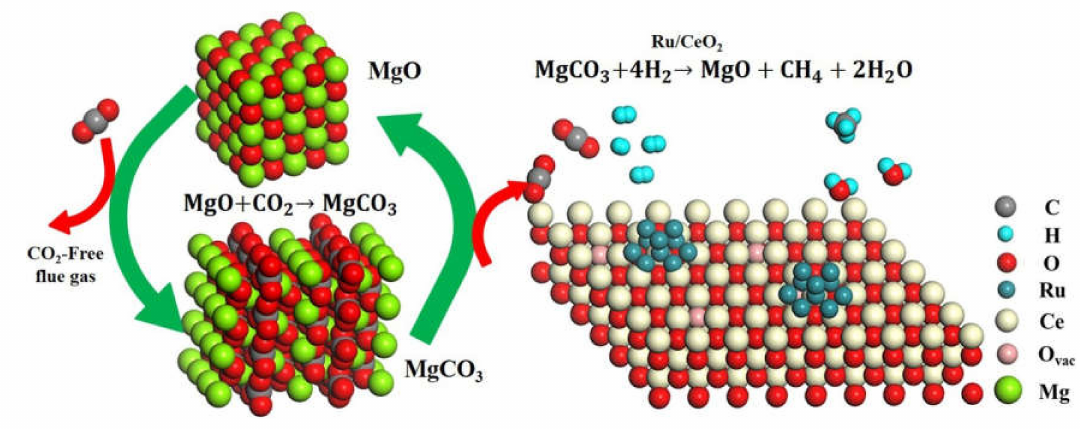
Figure 11. Schematic illustration for the CO 2 capture from the MgO sorbent phase and the conversion of captured CO 2 into CH 4 over the Ru / CeO 2 catalyst phase. Reproduced with permission from ref. [25]. Copyright 2020